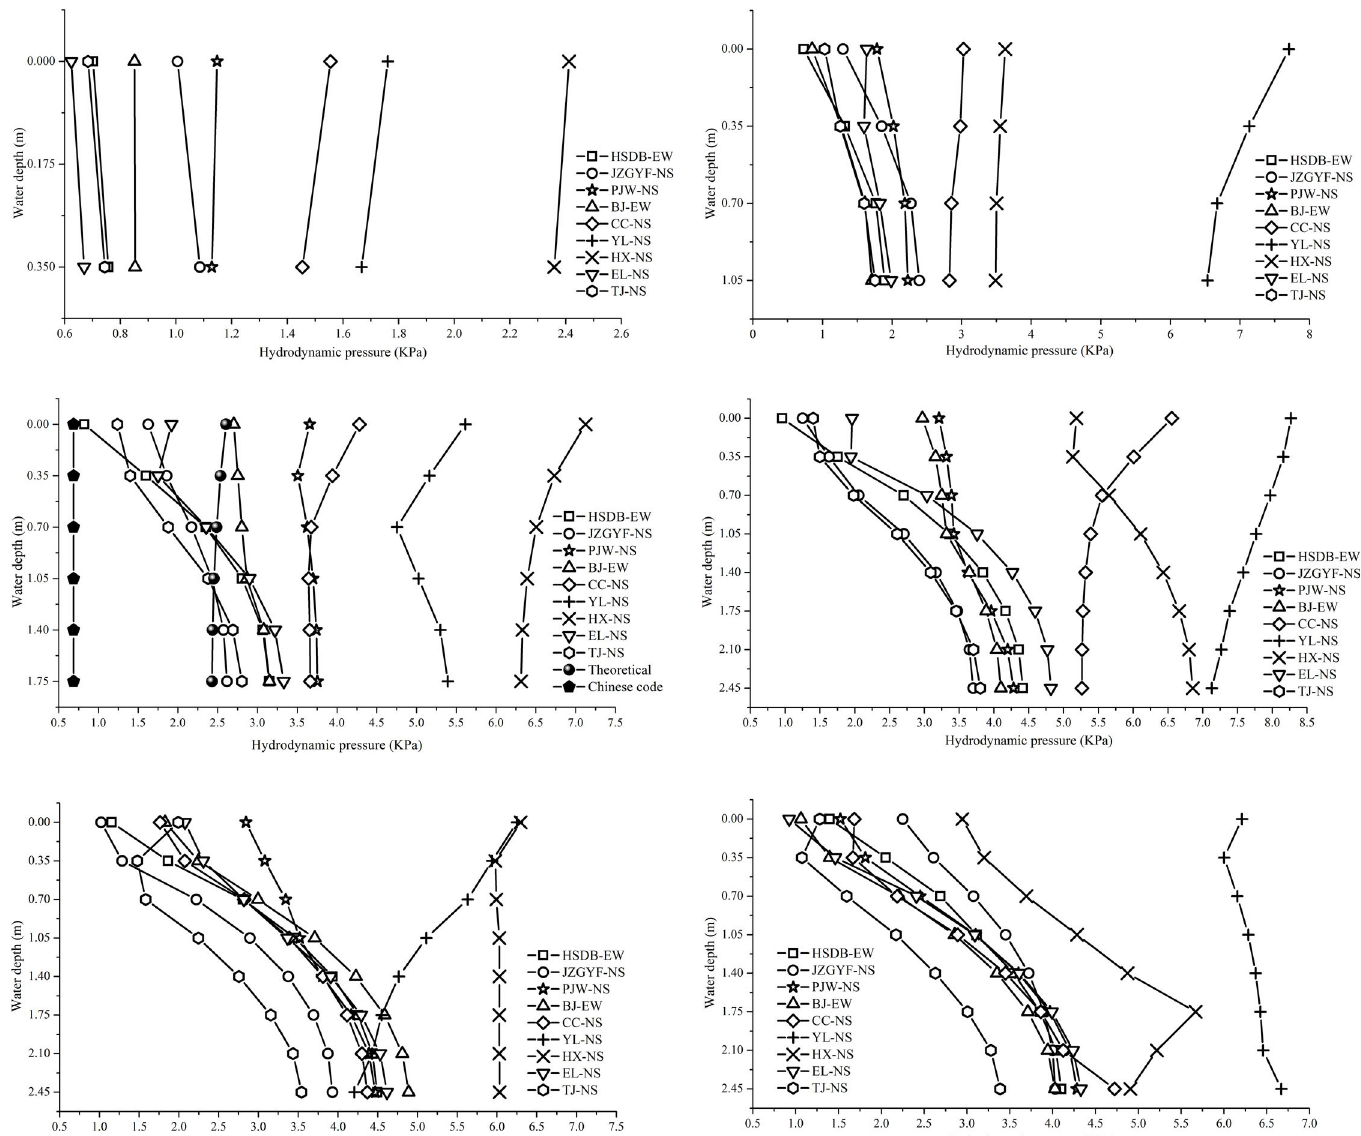
Fig 11. Maximum hydrodynamic pressure distributions at the tank wall at 1.0 m/s 2 peak acceleration. a) A-10% condition. b) A-30% condition. c) A-50% condition. d) A-70% condition. e) B-70% condition. f) C-70% condition. https://doi.org/10.1371/journal.pone.0265528.g011 shows a plot of the maximum hydrodynamic pressure distributions of the tank wall at different water storage heights under the same ground motion input with a 1.0 m/s 2 peak acceleration. It can be seen from Fig 14 that under short-period seismic motion actions, the maximum hydrodynamic pressures at the liquid level are similar and low at different water storage heights. With an increase in the water storage height, the hydrodynamic pressure increases rapidly, and the hydrodynamic pressure at the tank bottom is much greater than that at the liq- uid level. Under medium and long-period ground motion actions, the maximum hydrody- namic pressures of the liquid level differ at different water storage heights. With an increase in the water storage height, the hydrodynamic pressure increases slowly, and the hydrodynamic